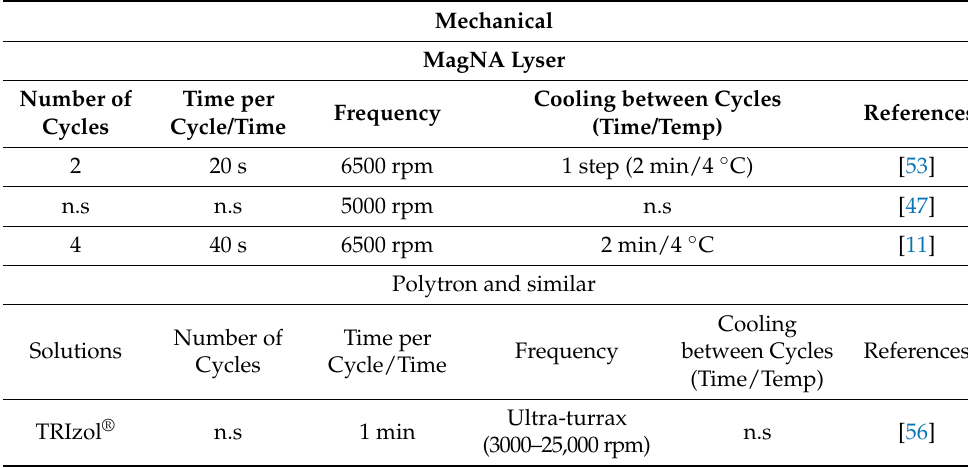
Table 1. Mechanical homogenization protocols; related parameters and used